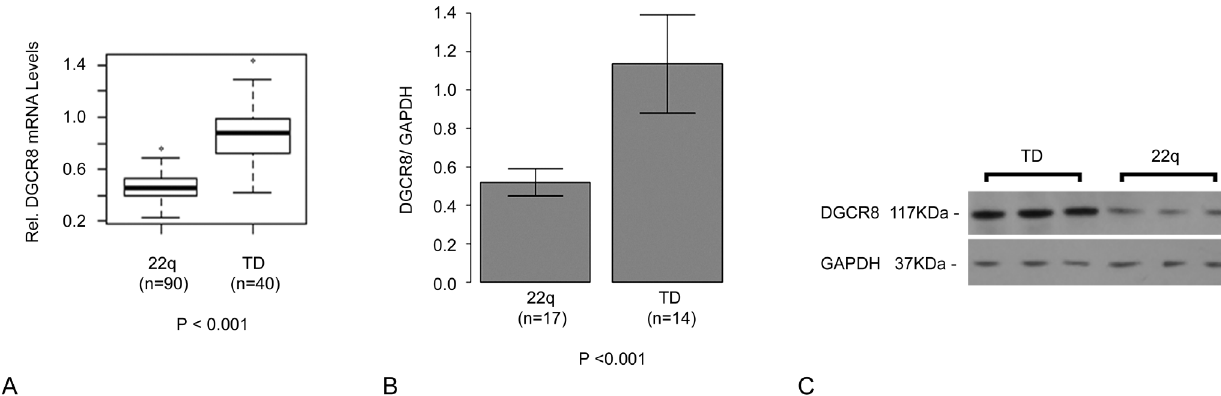
Figure 3. DGCR8 expression levels. a) box plots showing a decreased DGCR8 mRNA levels in subjects with 22q11DS compared to TD and b) DGCR8 protein expression levels measured by Western blot analysis shows a significant decrease in 22q11DS individuals when compared to TD controls. c) Representative Western blot showing decreased DGCR8 expression.